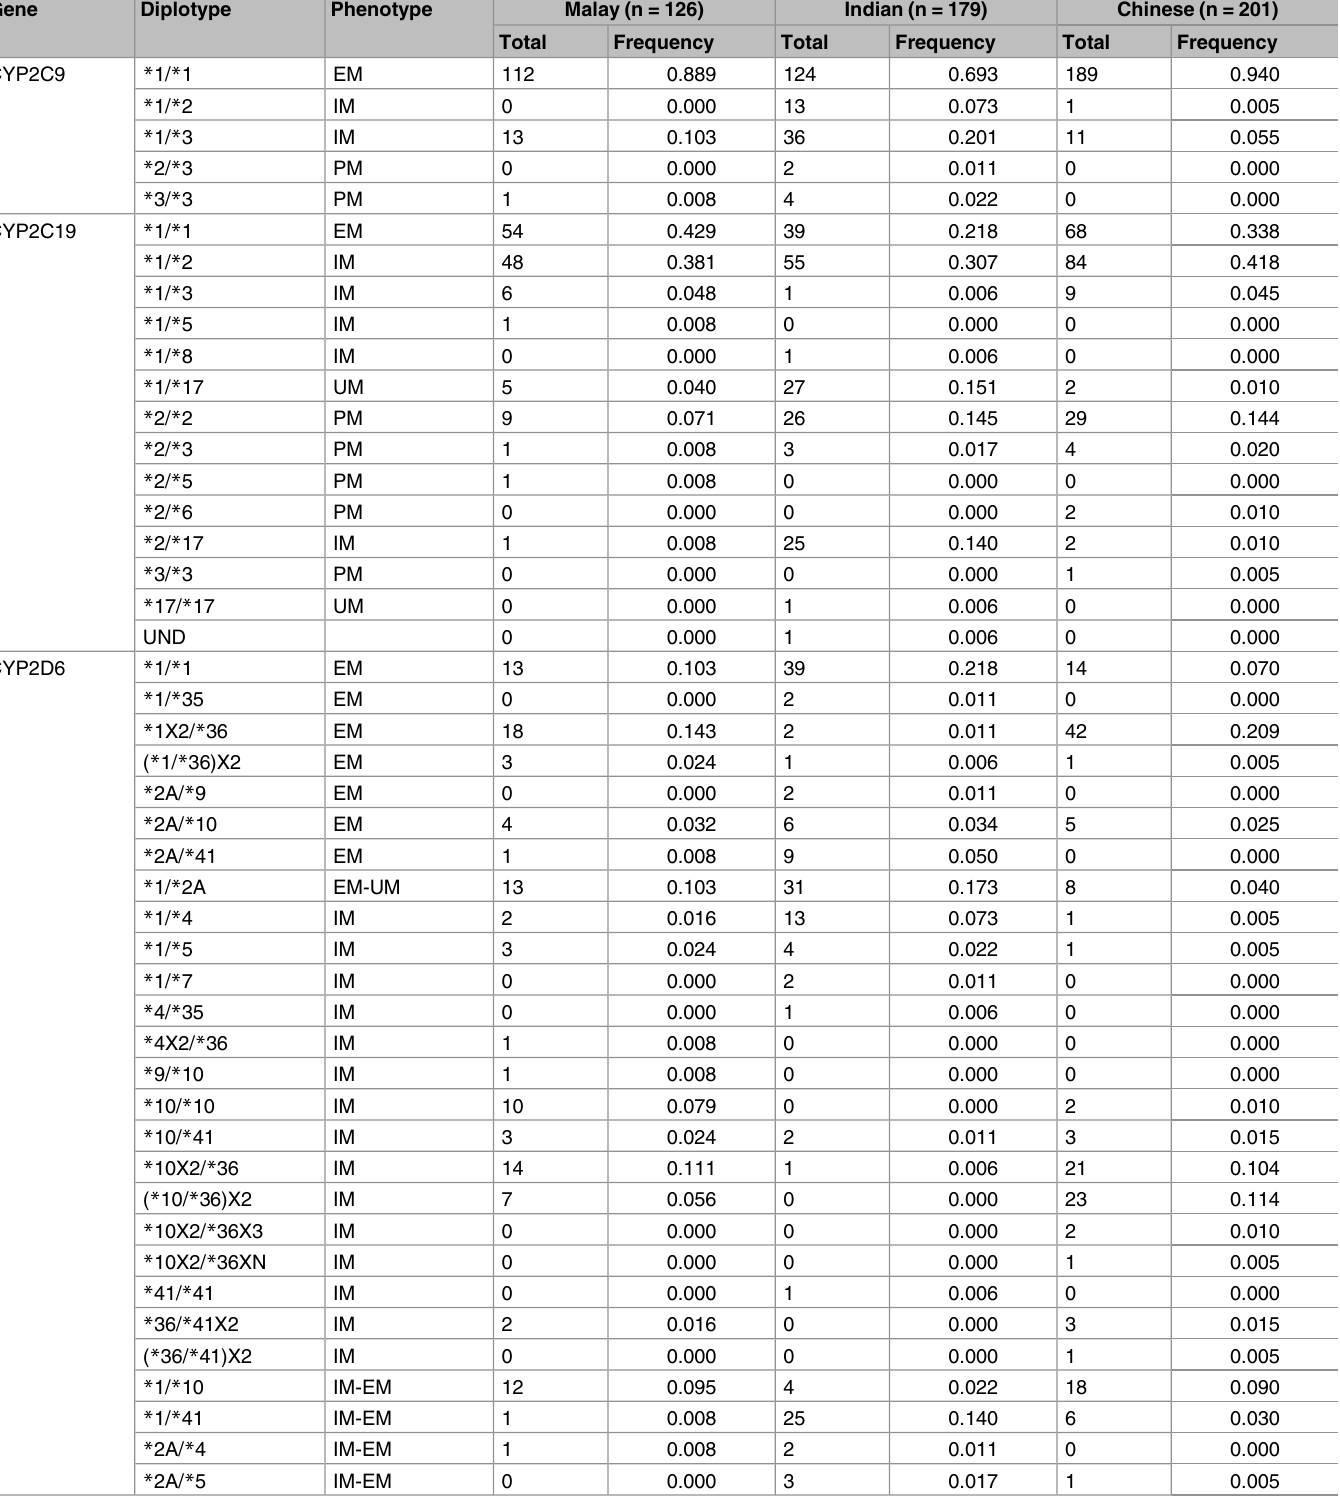
Table 4. Diplotype frequencies and functional classification of CYP2C9, CYP2C19, CYP2D6, CYP3A5 and VKORC1 in the Singapore population (n =